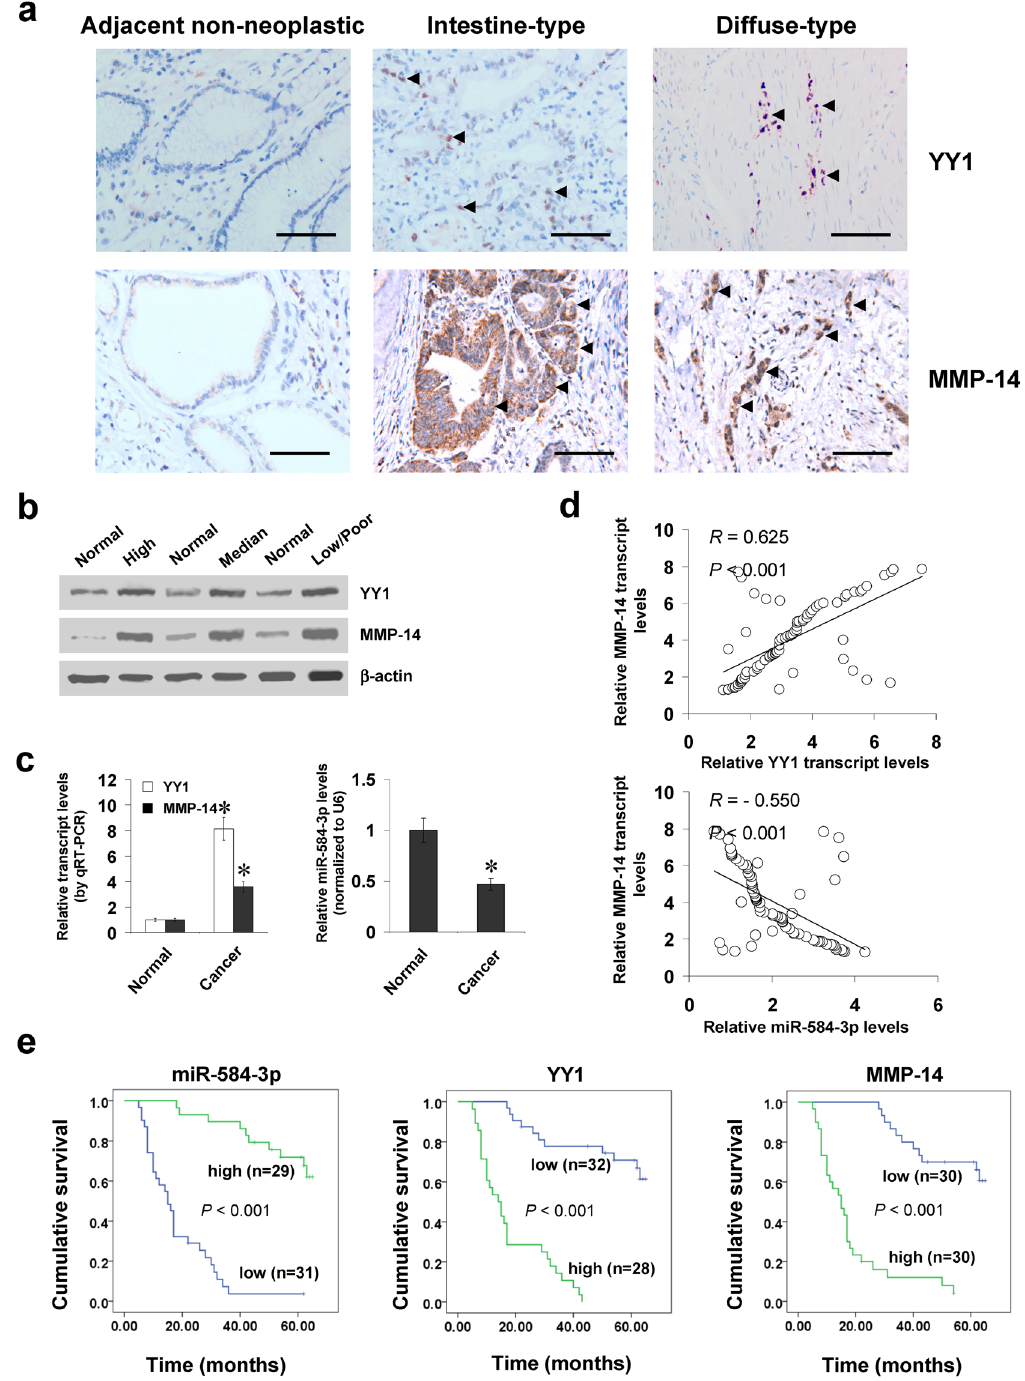
Figure 6. YY1 and miR-584-3p are positively or inversely correlated with MMP-14 levels in gastric cancer tissues. ( a ) Immunohistochemical staining showing the expression of YY1 and MMP-14 in the tumor cells of gastric cancer specimens (arrowheads, brown). Scale bars: 100 μ m. ( b ) Western blot assay indicating the protein levels of YY1 and MMP-14 in gastric cancer tissues with different differentiation, and those in normal gastric mucosa. ( c ) Real-time quantitative RT-PCR showing the transcript levels of YY1 , MMP-14 , and miR-584-3p in normal gastric mucosa (n = 80) and gastric cancer tissues (n = 80). ( d ) The correlation between MMP-14 transcript levels and YY1 or miR-584-3p expression in gastric cancer tissues (n = 80). ( e ) Kaplan–Meier survival plots of 60 well-defined gastric cancer cases with high or low expression of miR-584-3p, YY1, or MMP-14. * P < 0.01 vs.